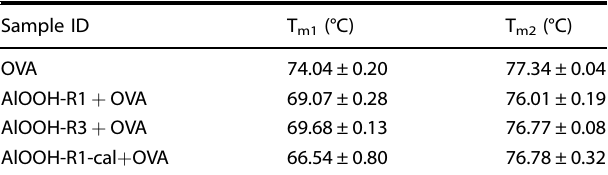
Table 6. The T m values of the protein in the solution and adsorbed on the AlOOH nanorods. Sample